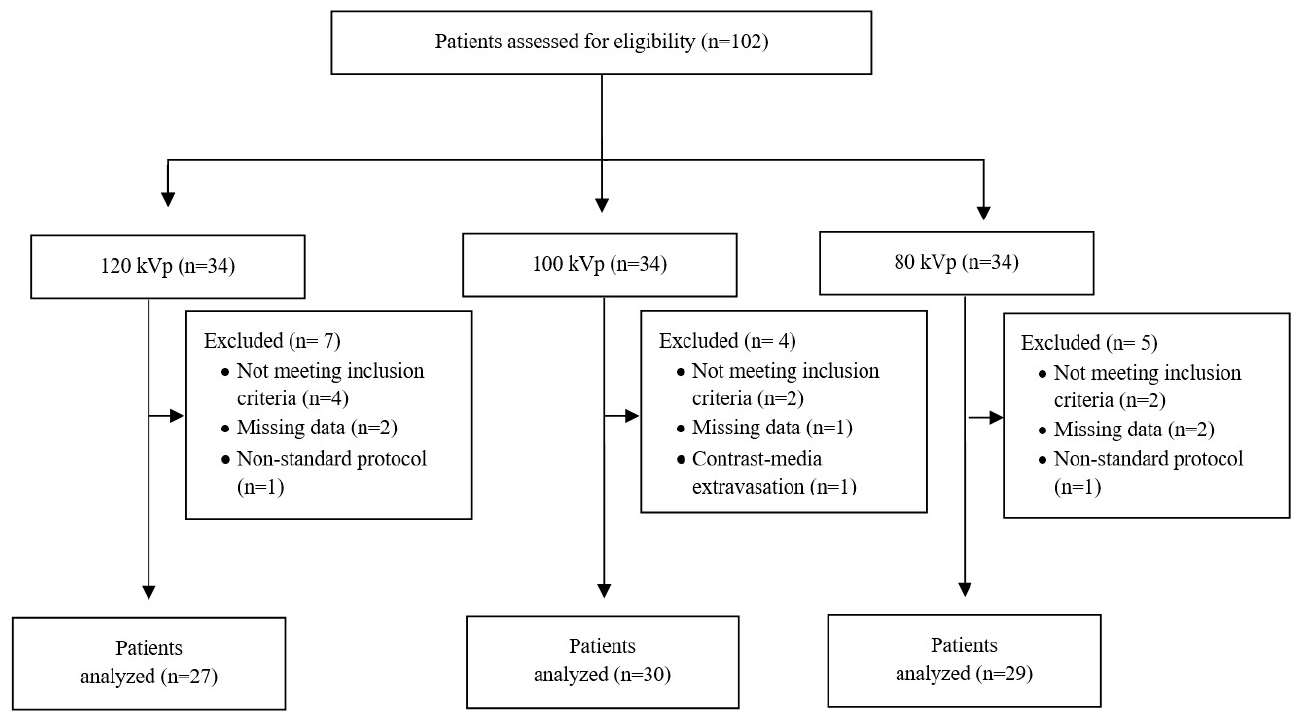
Figure 1. Flow chart of the study. kVp, kilovoltage peak.